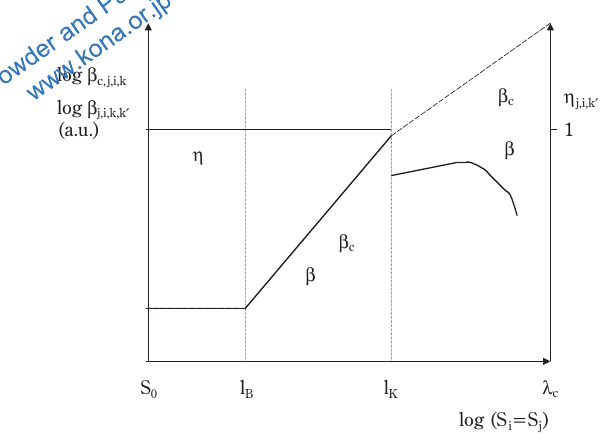
Fig. 4 Collision and overall agglomeration rate constant against the common size of mother particles for collision of parti- cles of the same size. Case of high growth